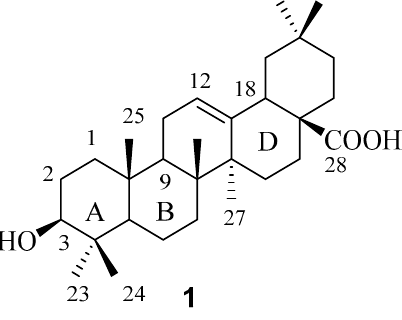
Figure 2. Structure of oleanolic acid (OA).